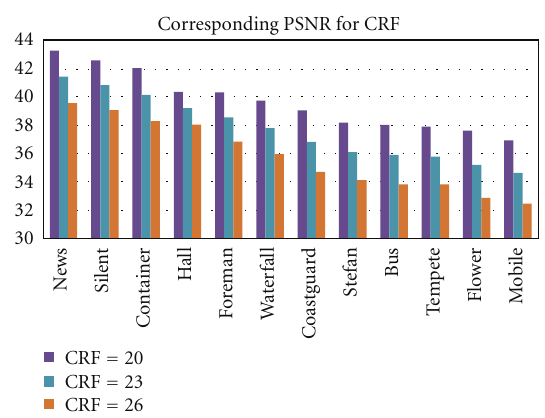
Figure 17: Correspondence between PSNR and CRF setting. same costs are achieved with their respective default